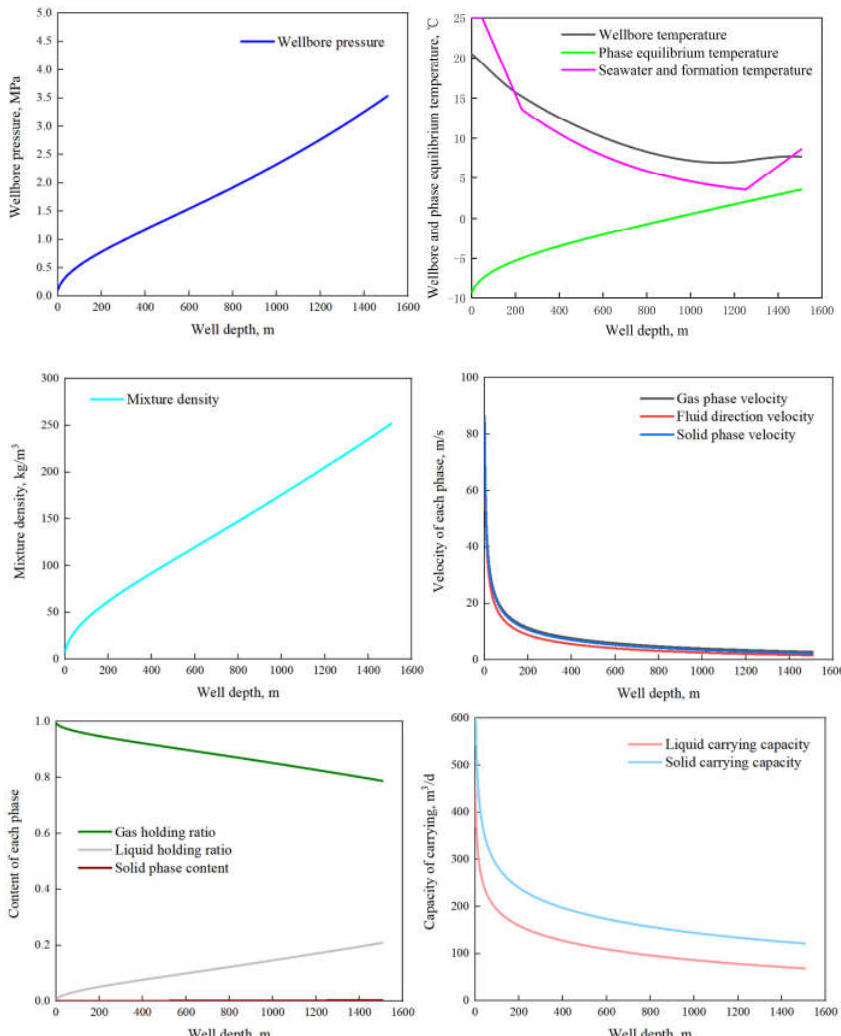
Figure 3. Flow behavior of liquid-carrying wellbore with foam injection volume of 60 m 3 /min. The variation rules of parameters under different foam injection quantities are shown in Figure 4.